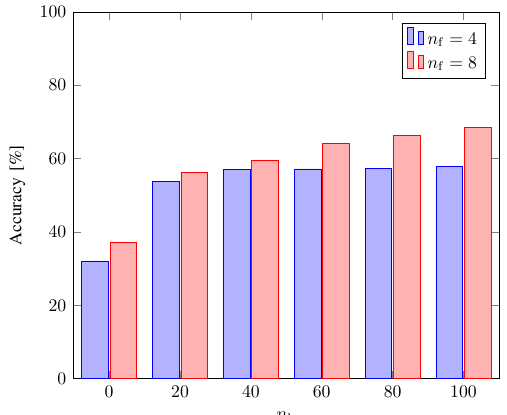
Figure 6. Classification accuracy as a function of the number of hidden neurons, n h in a single hidden layer ( n d = 1) for Mermin ( n f = 4) and Svetlichny ( n f = 8) features. No hidden neuron ( n h = 0) corresponds to linear optimization with no hidden